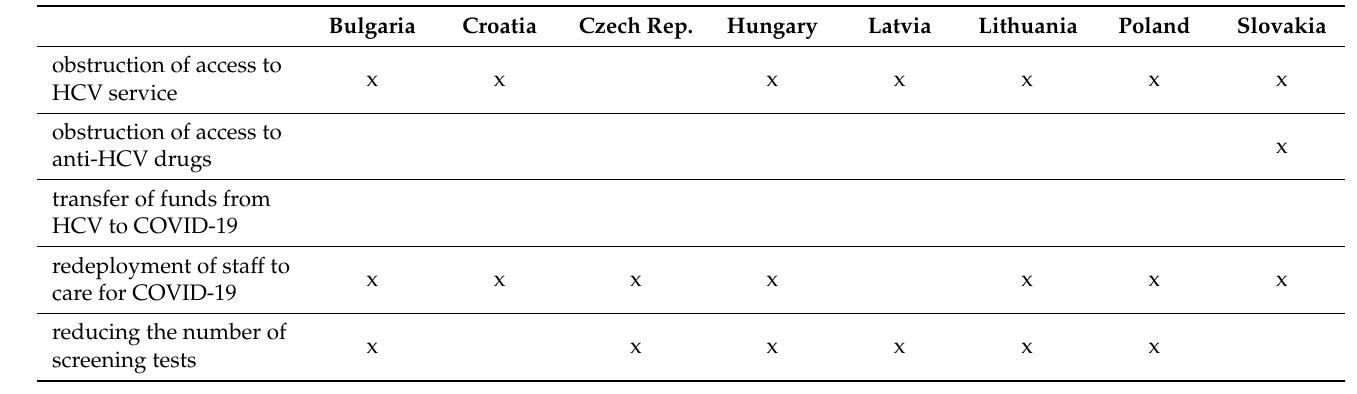
Table 2. Effect of COVID-19 on HCV